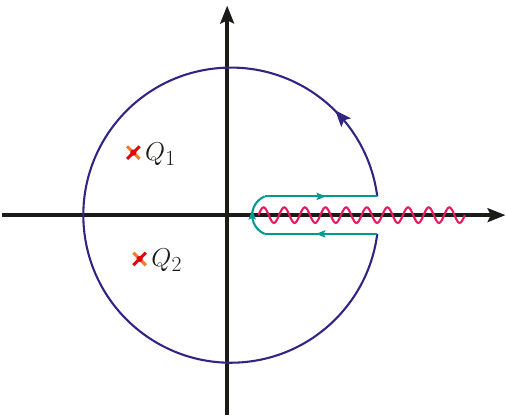
Figure 1 . Circuit of integration of 1